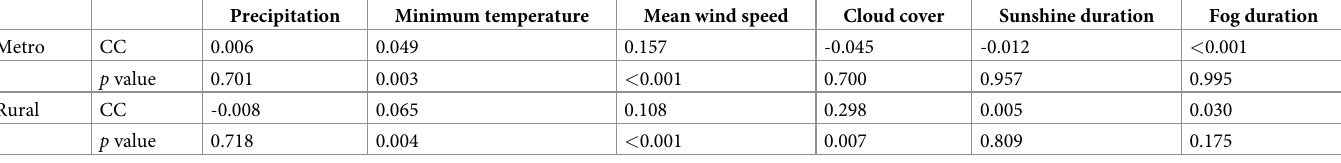
Table 4. Results of Pearson’s correlation analysis between injury severity (mean KTAS) with weather factors.